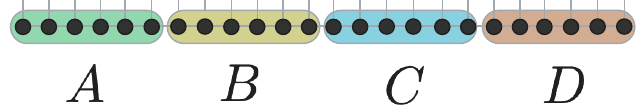
Figure 2: Partitions considered for the stationary state observables. Each